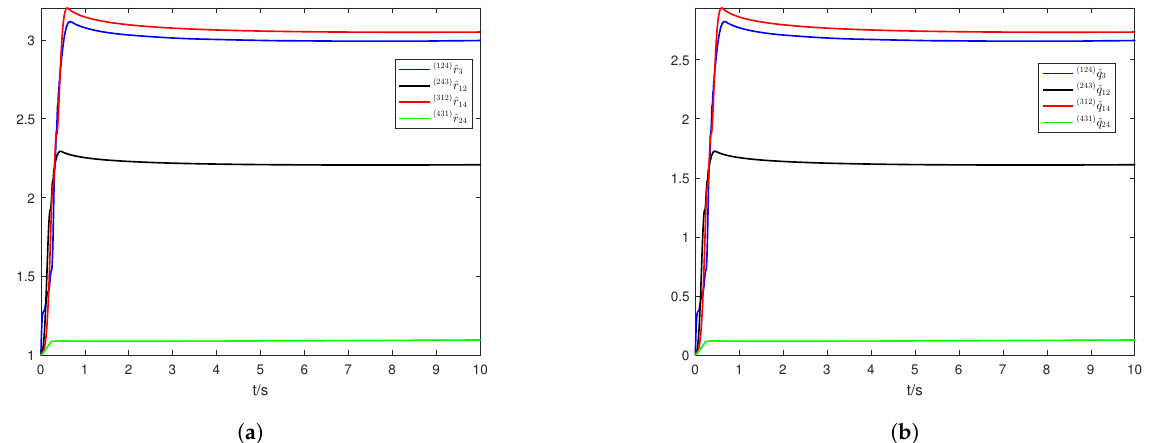
Figure 5. The estimation of parameters ( 124 ) ˆ r 3 , ( 243 ) ˆ r 12 , ( 312 ) ˆ r 14 , ( 431 ) ˆ r 24 and ( 124 ) ˆ q 3 , ( 243 ) ˆ q 12 , ( 312 ) ˆ q 14 , ( 431 ) ˆ q 24 shown in sub-pictures ( a , b